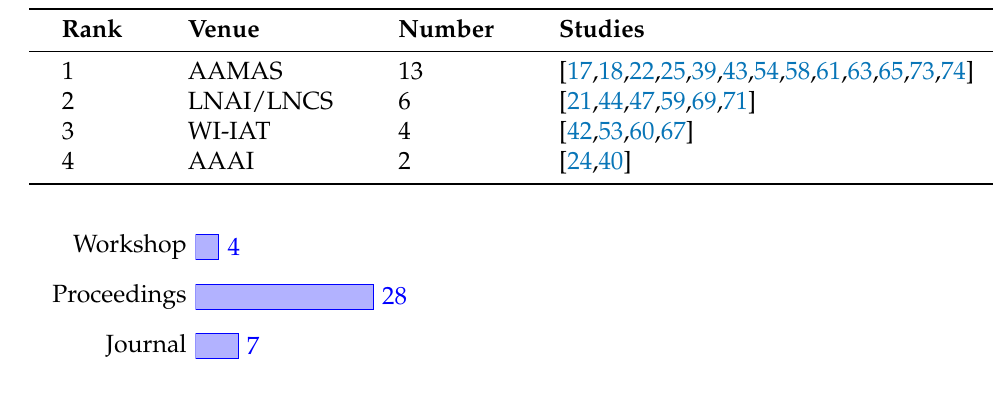
Figure 7. Venue types: Workshops [21,42,69,74], Proceedings [17,18,22,24,25,39,40,43,44,46,47,53,54, 56,57,59–67,70,71,73,75], and Journals [23,41,45,55,58,68,72].